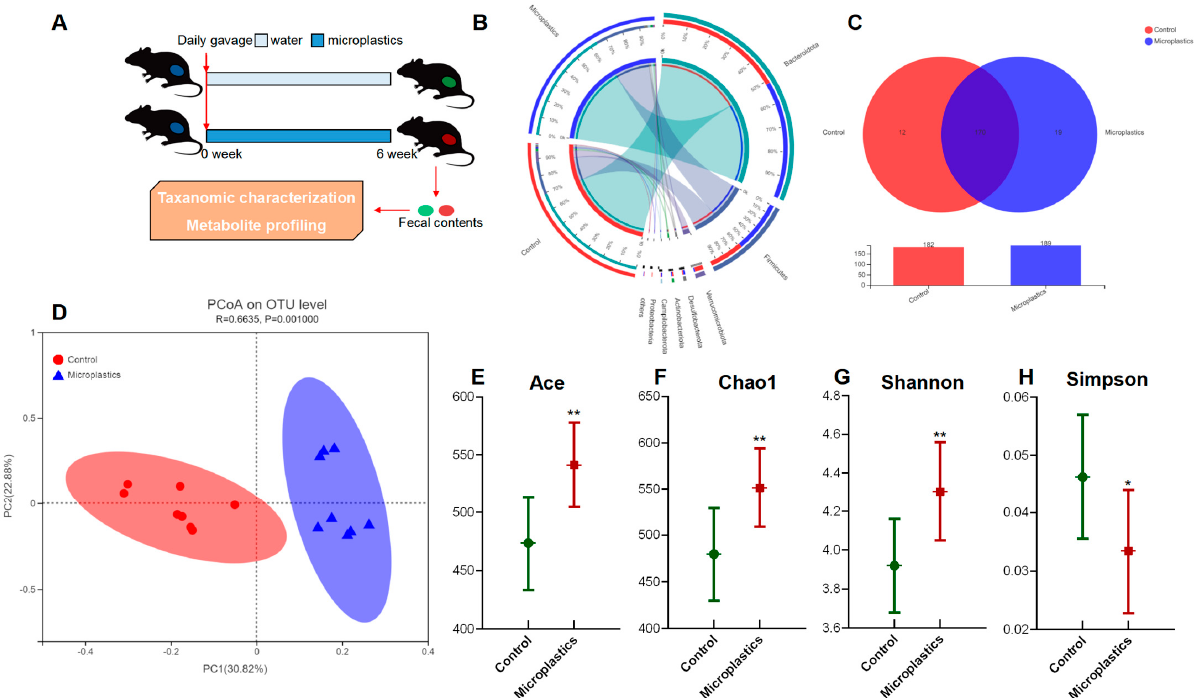
Figure 1. MP-induced alterations in the mouse gut microbial community. ( A ) Experimental design. ( B ) Circos diagram for component profiles of the gut microbial community at phylum level ( n = 8). ( C ) Venn diagram for component profiles of the gut microbial community at species level ( n = 8). ( D ) Component profiles analyzed by PcoA model ( n = 8). ( E – H ) Alpha diversity indices of Ace, Chao1, Shannon, and Simpson ( n = 8, * p < 0.05, ** p < 0.01).